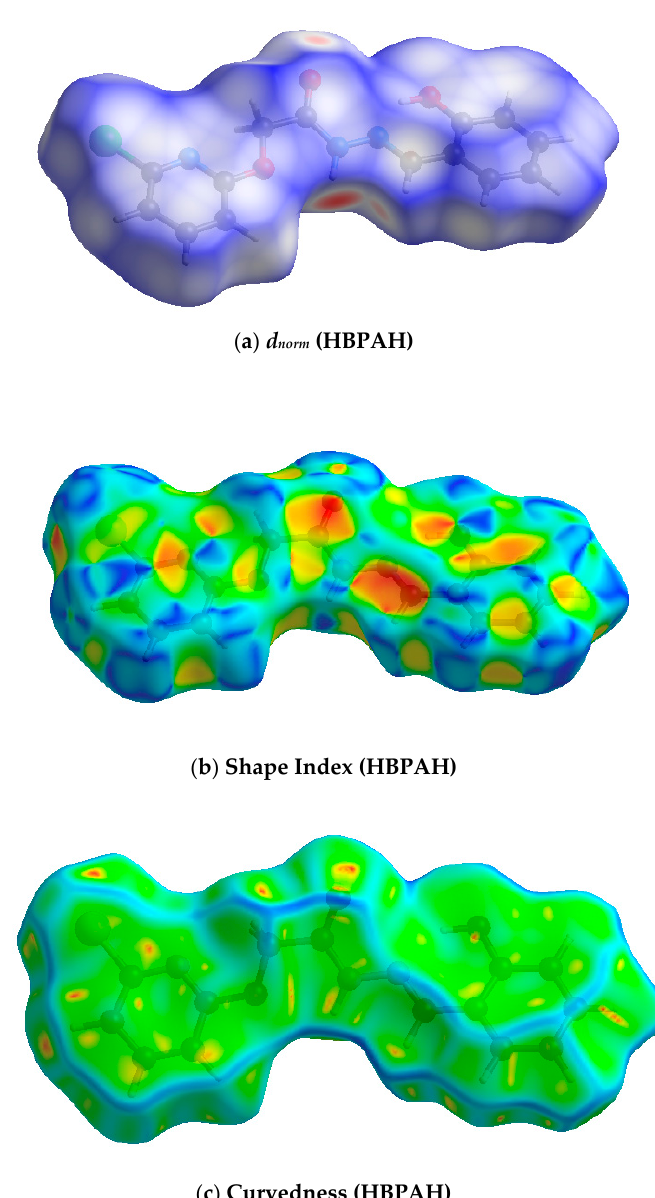
Figure 6. Hirshfeld surfaces of the entitled compound mapped over ( a ) d norm , ( b ) shape index, and ( c ) curvedness, respectively, for HBPAH (1 a.u. of electron density = 6.748 e.Å-3).